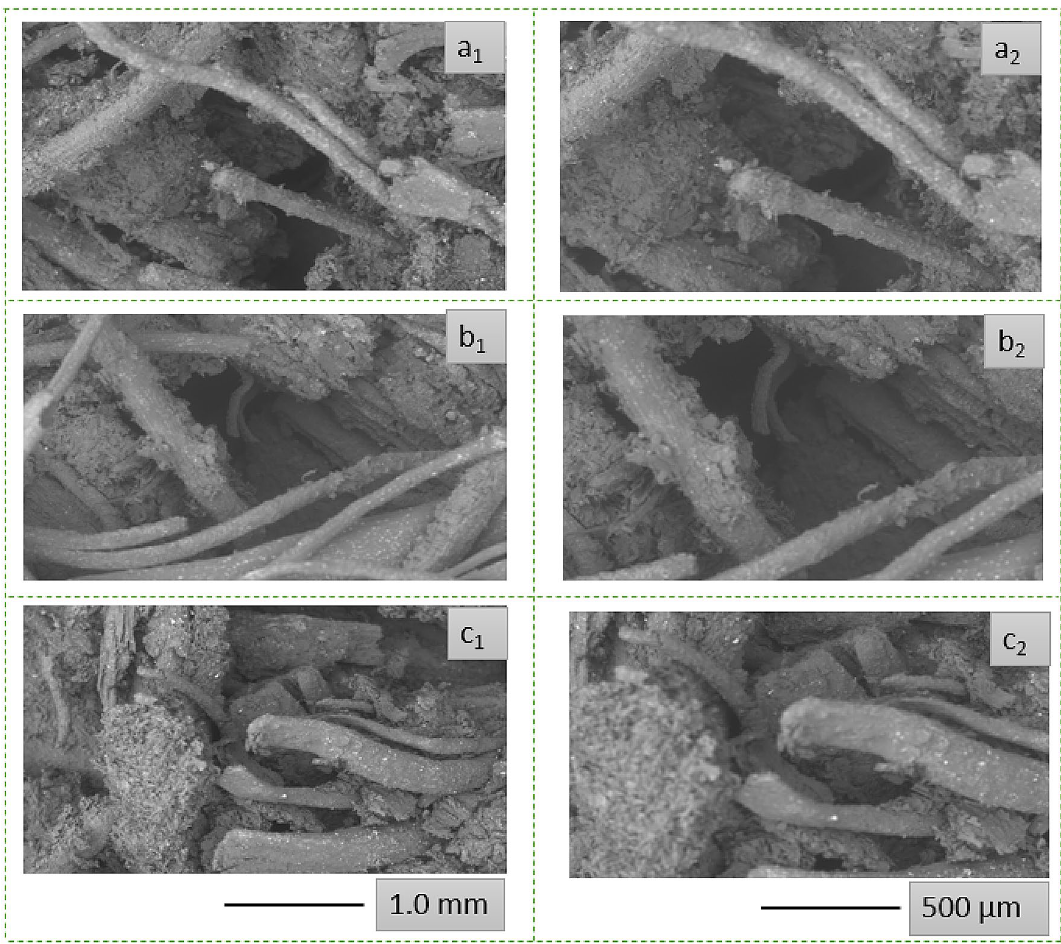
Figure 6. SEM images of fractured coir (LCF and CFC) reinforced biocomposites: a 1 and a 2 stands for C@BC 1 biocomposite at 1.0 mm and 500 µm scale, b 1 and b 2 stands for C@BC 2 biocomposite at 1.0 mm and 500 µm scale, c 1 and c 2 stands for C@BC 3 composite at 1.0 mm and 500 µm scale.